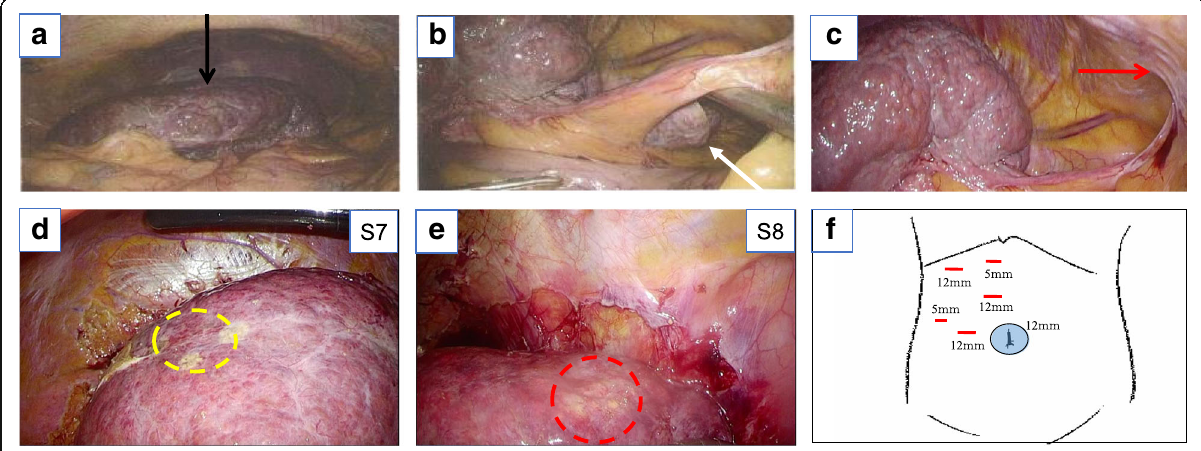
Fig. 4 Intraoperative findings show the absence of the left hepatic lobe. a Arrow ( black ) shows the entire liver. The gross appearance of the liver is nodular cirrhosis. b Arrow ( white ) shows no hypertrophy of the caudate lobe. c This image shows complete agenesis of the liver to the left of the falciform ligament ( red arrow ). d Circle ( yellow ) shows the lesion of S7. e Circle ( red ) shows the lesion of S8. f The schema demonstrates the placement of each